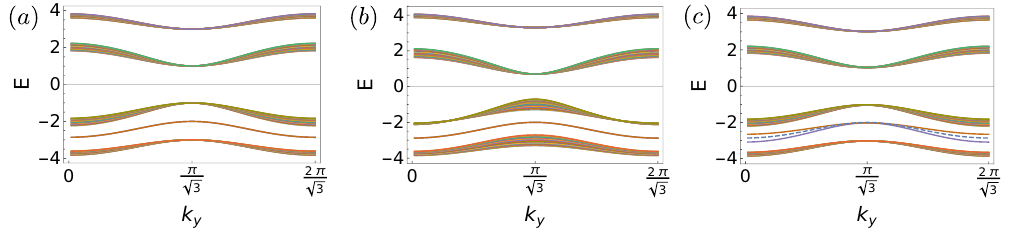
Figure 13: Protection of the edge states. In panel (a) we plot the spectrum of the model with open boundary conditions in the absence of perturbations. The edge states are visible near the center of the two lower bands. In Panel (b) and (c) we consider the effect of pertubations: (b) Mirror-symmetry preserving g γ , keeping 2,2 the edge states intact; (c) Mirror-symmetry breaking perturbation g γ , for which 3,1 the edge states split symmetrically around the unperturbed edge state (dashed line). = Here t = 1.0, g = 0.3 and W 0